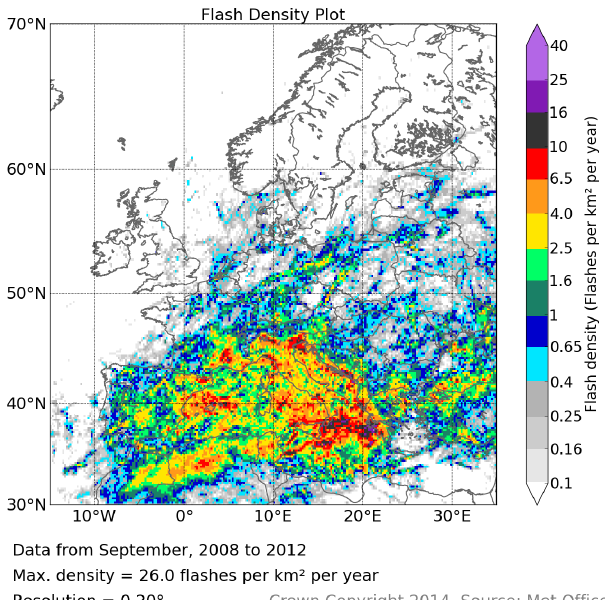
Fig. 13. Detected lightning flash density for